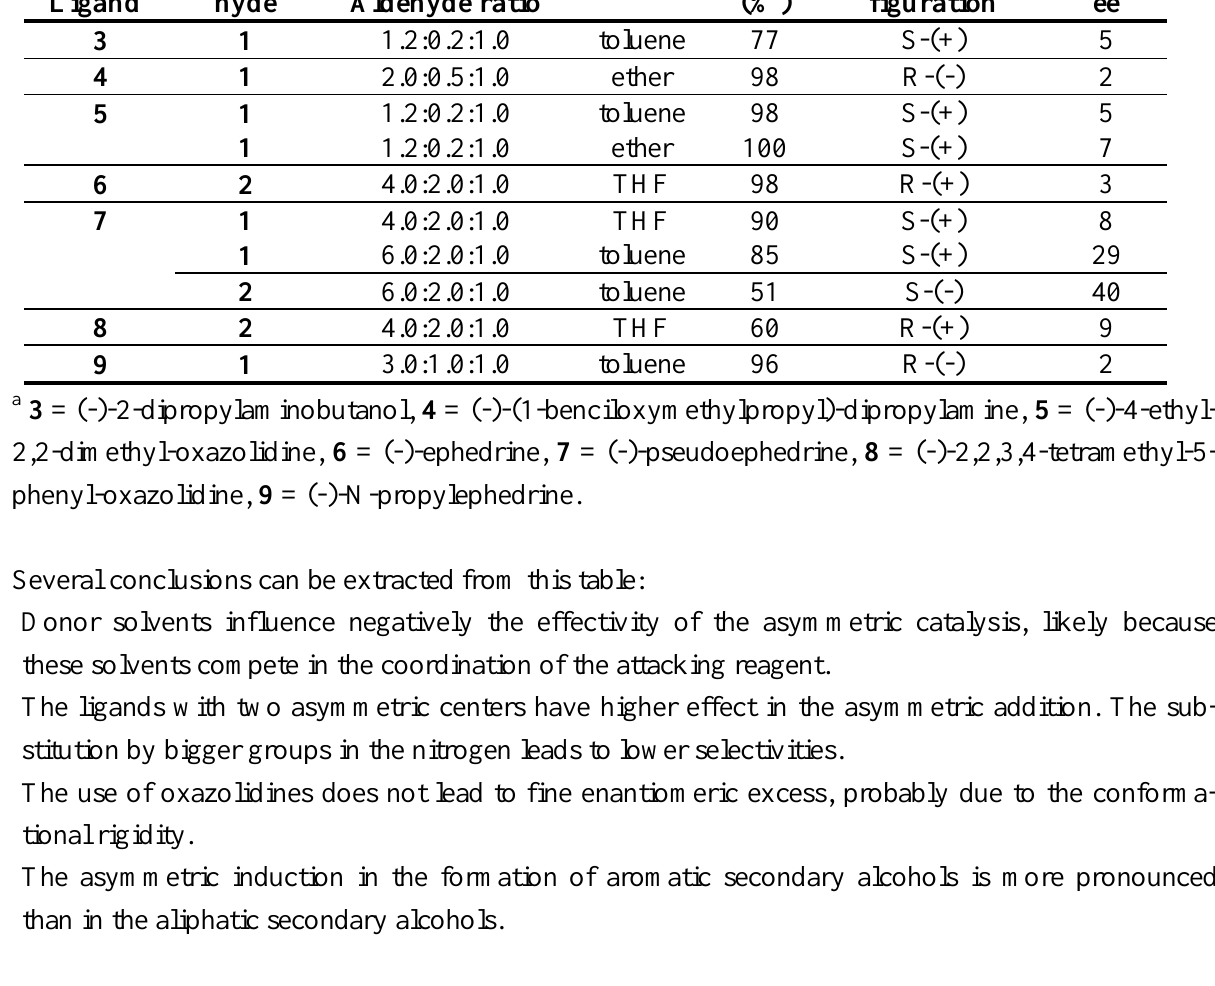
ligands. Absolute Con-